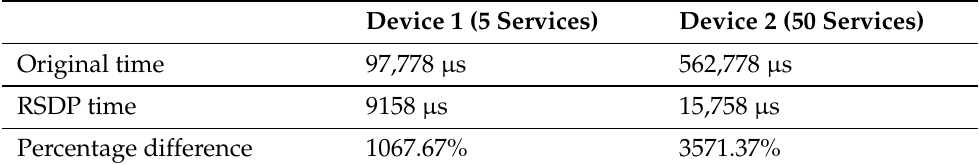
Table 4. Time of the Rapid Service Discovery compared with the original service discovery when using the optimal link-layer settings for both Device 1 (5 services) and Device 2 (50